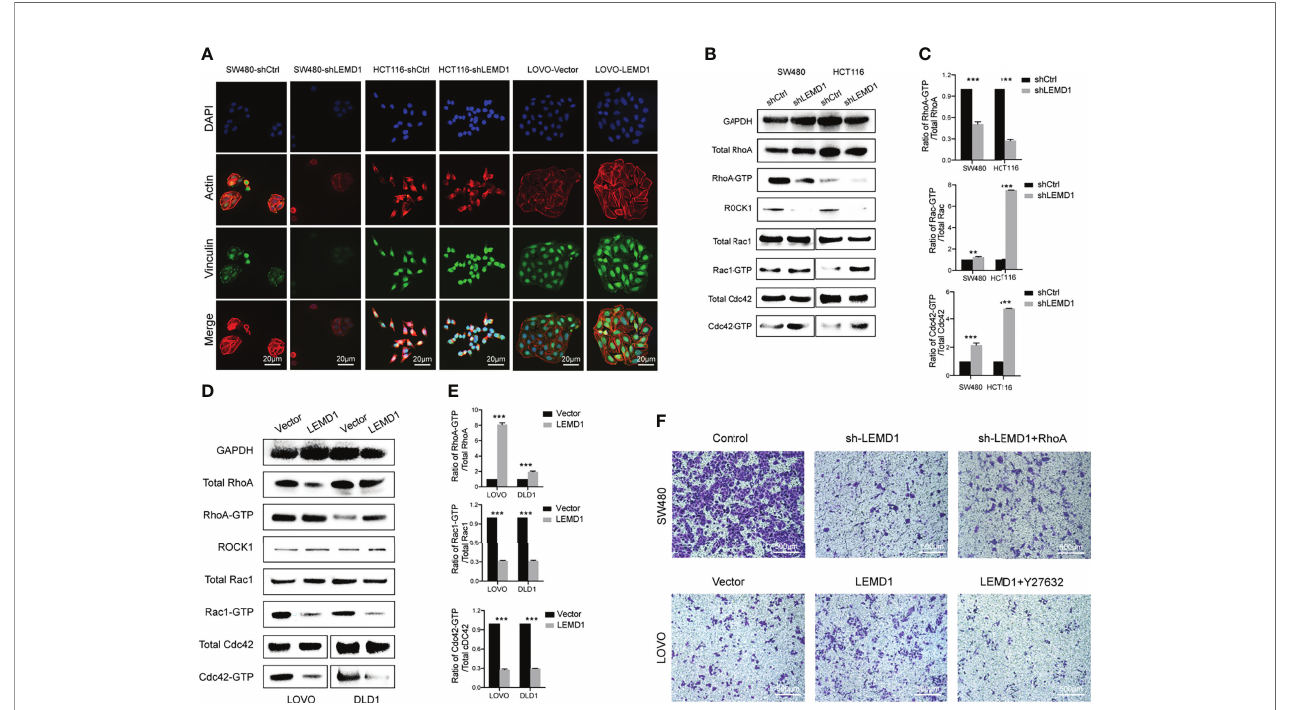
FIGURE 8 | LEMD1 promotes CRC metastases through the RhoA/ROCK pathway. (A) Actin and Vinculin changes after knockdown/overexpression LEMD1; (B, C) Knockdown of LEMD1 could decrease RhoA activity while activating GTP-Rac and GTP-Cdc42; (D, E) Overexpression of LEMD1 could activate GTP-RhoA and decrease the activity of GTP-Rac and GTP-Cdc42; (F) Overexpression of RhoA partially restored the inhibitory effect of knockdown of LEMD1 on cell migration; Y27632 could reduce the effect of LEMD1 on cell migration. **p < 0.01; ***p <